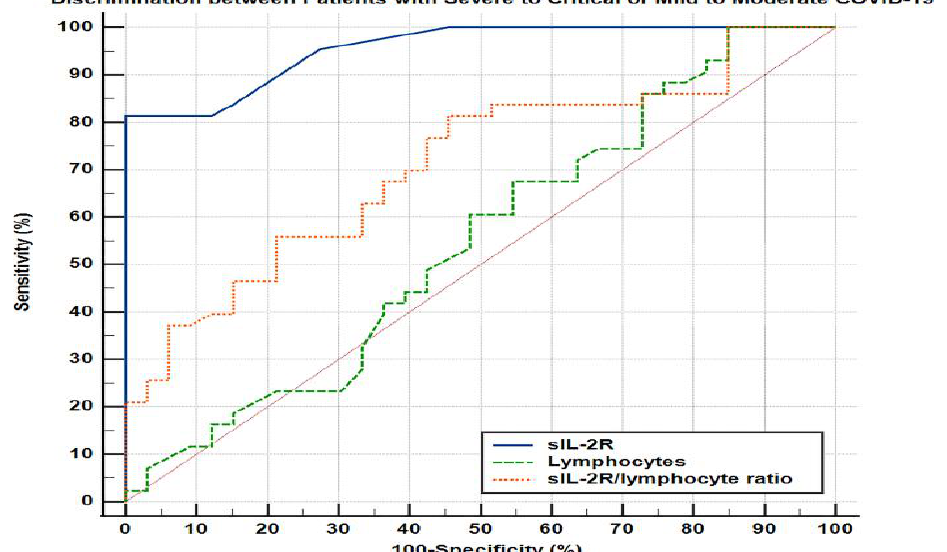
Figure 1. ROC curve illustrating performance of sIL-2R (AUC=0.955), lymphocyte count (AUC=0.549), and sIL-2R/lymphocyte ratio (AUC=0.711) in discrimination between patients with severe to critical and mild to moderate